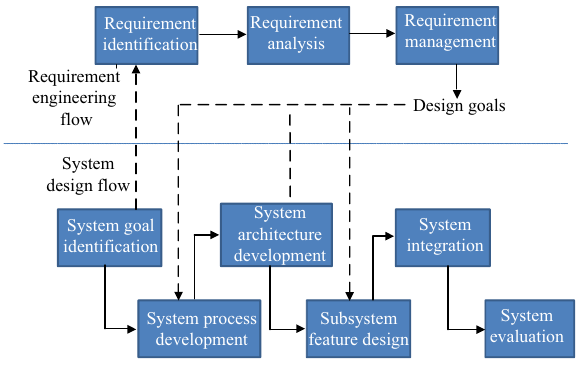
Fig. 2 Requirement engineering flow and system design flow and the interaction between the flows